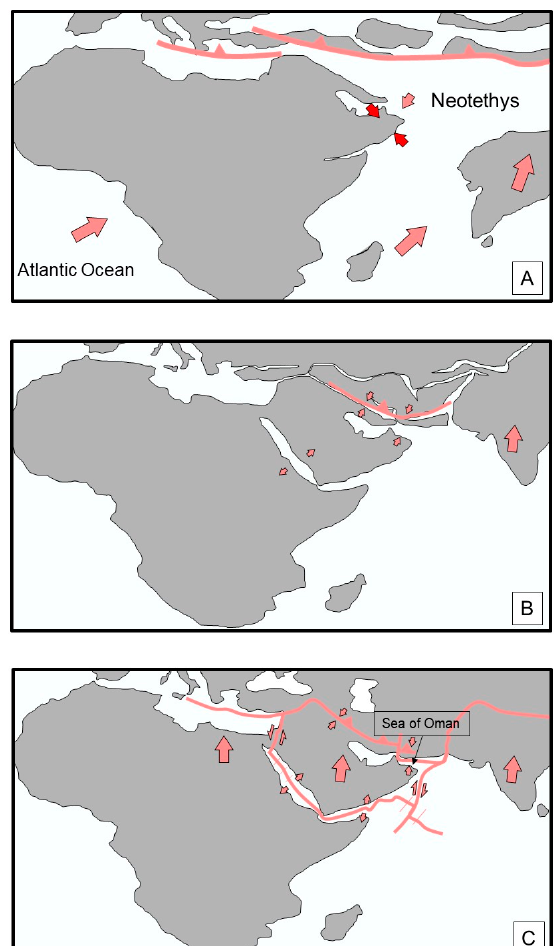
Figure 3. Palaeographic reconstruction during: ( A ) Late Cretaceous, ( B ) Neogene and ( C ) today, modified mainly from [9].